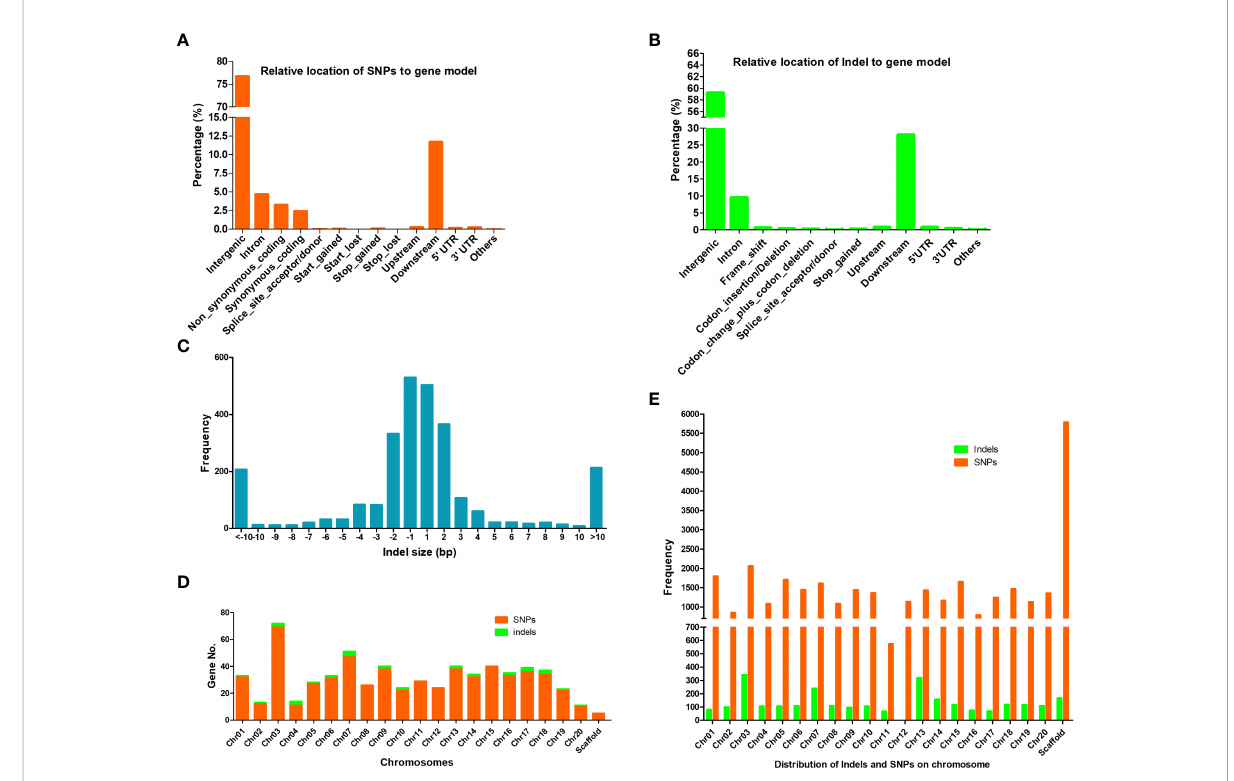
FIGURE 2 SNPs and indels in gene models and on chromosomes. (A) Relative location of SNPs to gene model. (B) Relative location of indels to gene model. (C) Indels size-frequency distribution. (D) Distribution of mutated genes caused by SNPs (Nonsynonymous substitution and alternative splicing) and indels (codon insertion/deletion, frame shift and alternative splicing) on soybean chromosomes. (E) Distribution of SNPs and indels on soybean